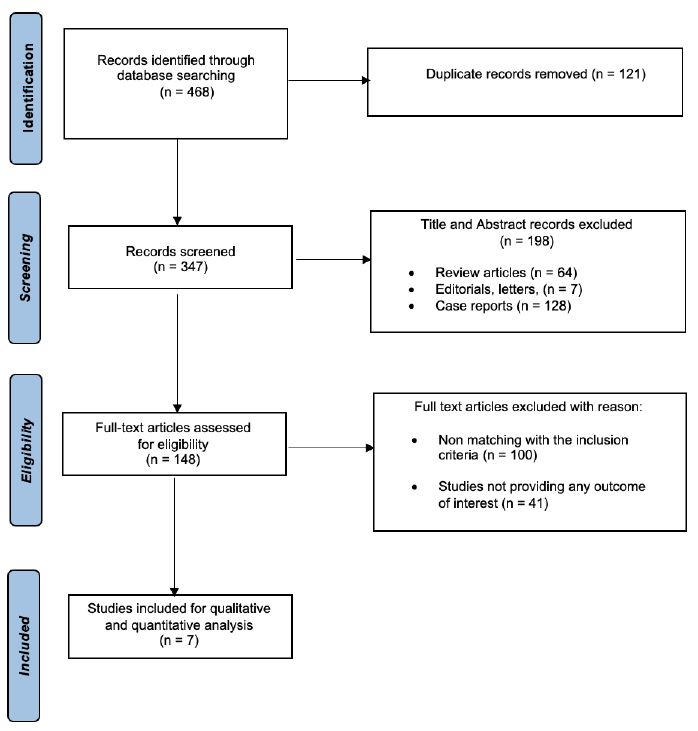
Figure 1. Study flow chart. Table 1. Summary of published research: Baseline characteristics among eligible studies testing the diagnostic perfor- mance of preoperative magnetic resonance imaging.